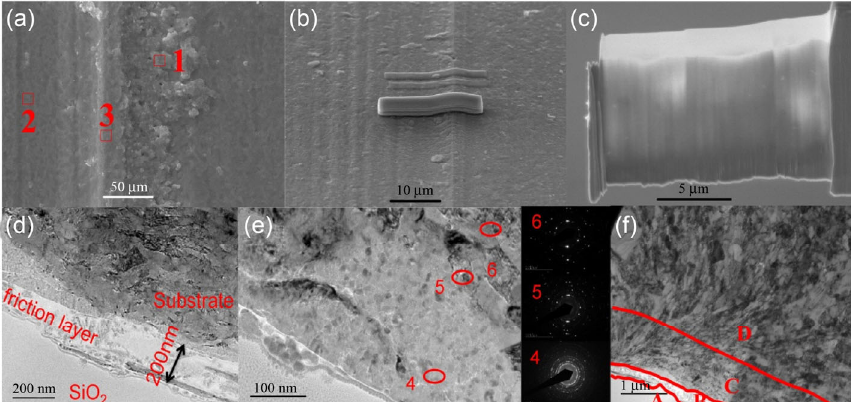
Fig. 23 SEM and TEM images of worn surfaces on disks lubricated with BP-16C at 75 mg/L: (a) SEM images of worn surfaces on disk; (b) the sampling place of samples using FIB; (c) TEM specimens by preparing in FIB; (d) TEM images of worn surfaces; (e) TEM images of substrate and the selected area electron diffraction (SAED) images; (f) TEM images of frictional layer.